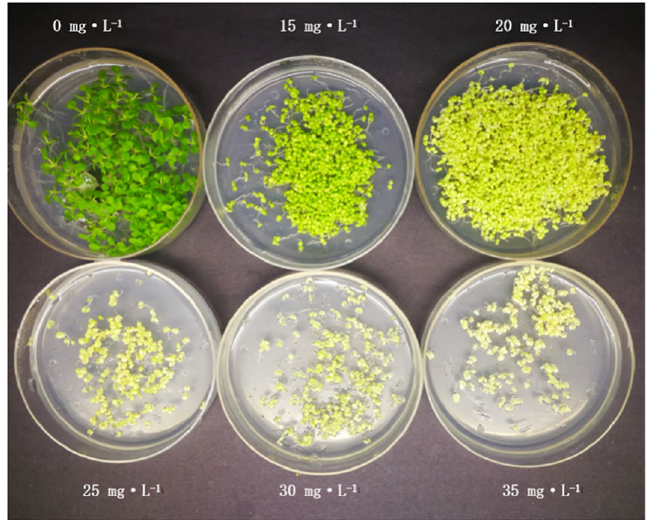
Figure 6. Growth status of wild-type tobacco in different concentrations of hyg.